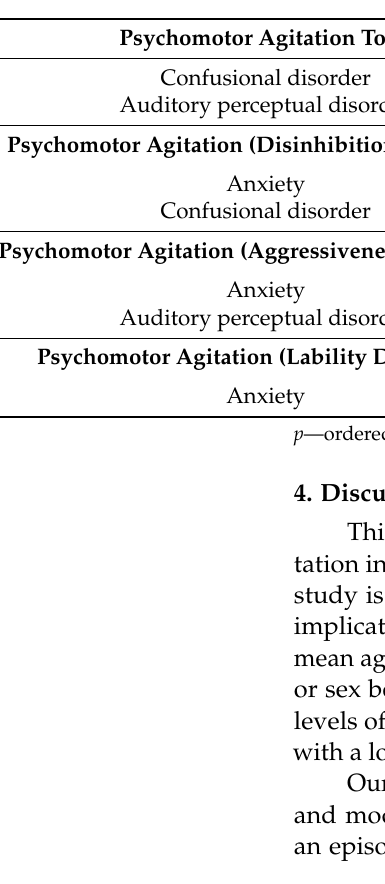
Table 5. Evaluation of the effect of variables on psychomotor agitation—ordered logistic